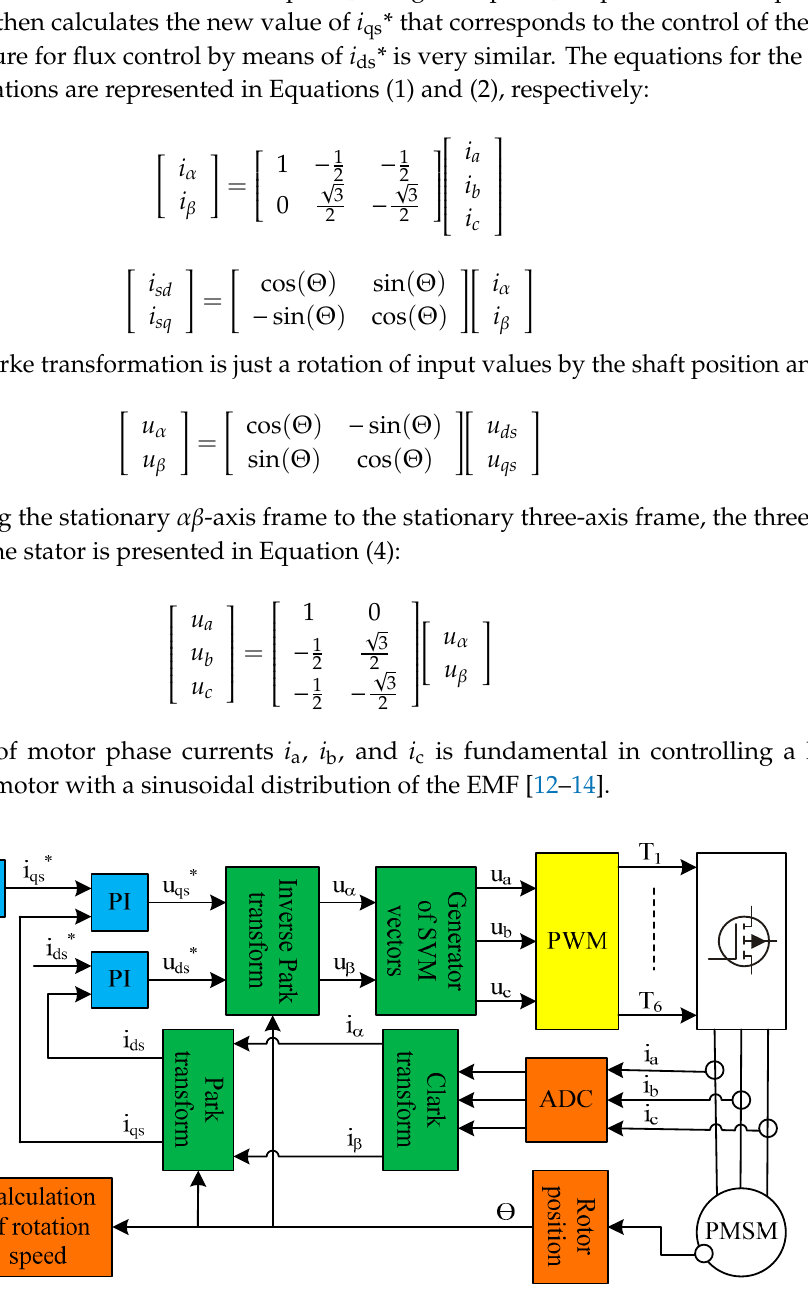
Figure 3. Diagram of signal flows for a permanent magnet synchronous motor (PMSM).